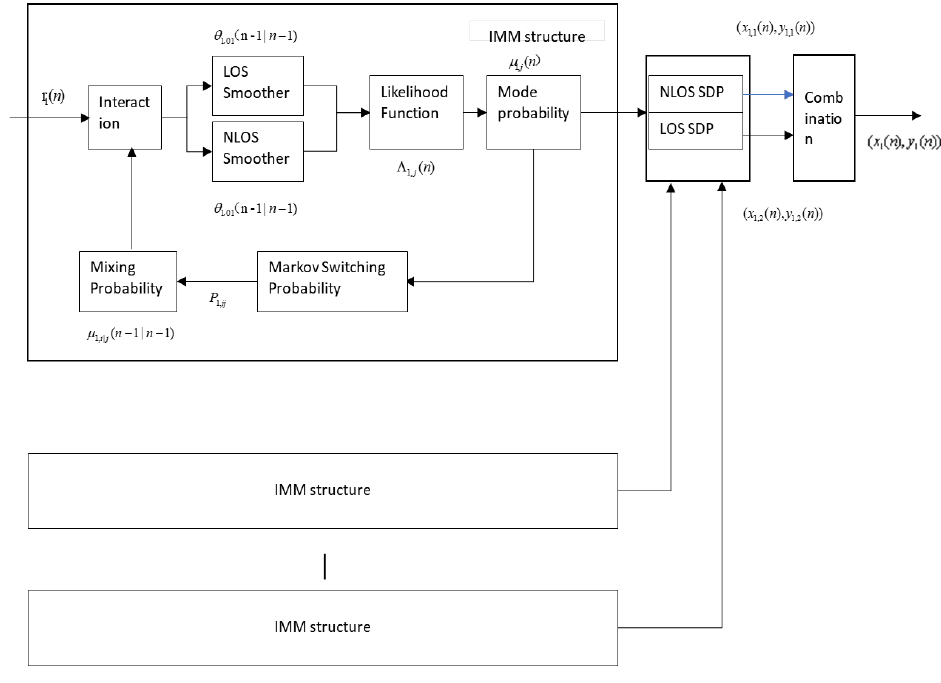
Figure 1. The flow chart of the proposed algorithm.